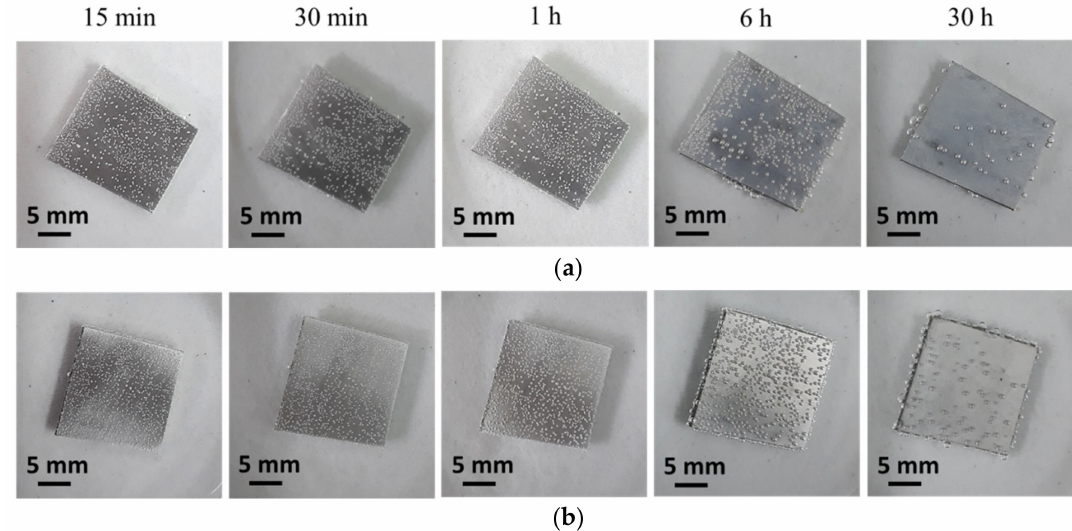
Figure 9. Optical micrographs showing the surface of ( a ) AM60; ( b ) AMX601 alloys during the immersion in NaOH solution (pH ≈ 10.5) at room